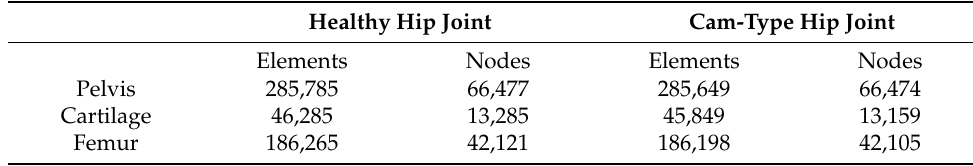
Table 2. The number of elements and nodes of the pelvis, femur, and cartilage of the healthy and Cam-type hip joints, considering a mesh size of 0.65